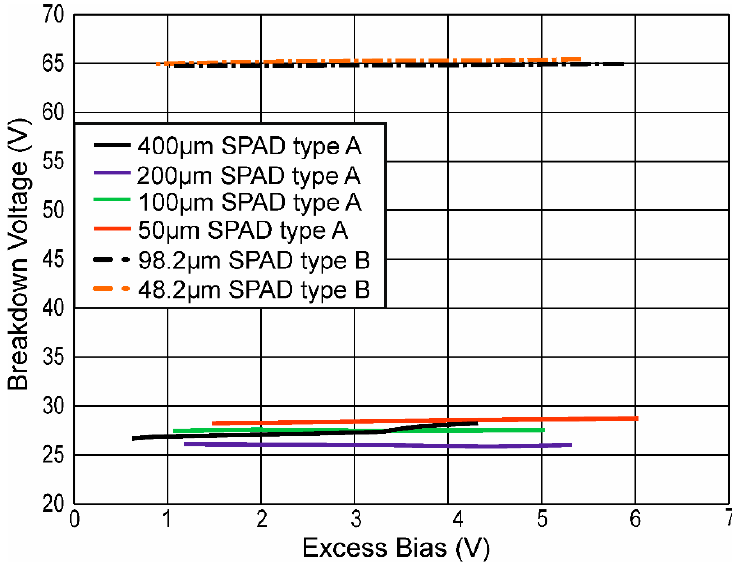
Figure 7. Breakdown voltage vs. excess bias.